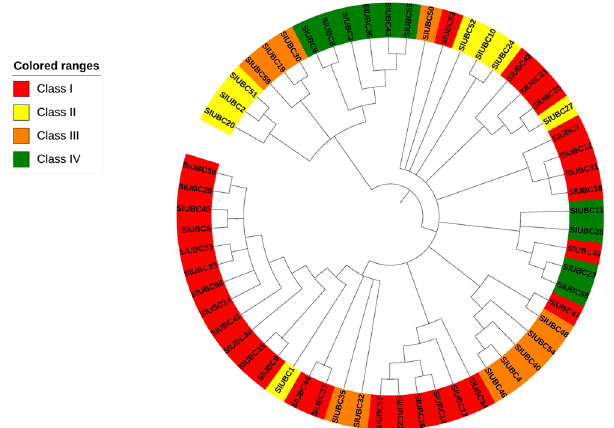
Figure 2. The phylogenetic tree of the Solanum lycopersicum E2 members is constructed by Neighbour-Joining method with 1000 bootstrap values. The E2 enzymes are divided into four classes and represented by different